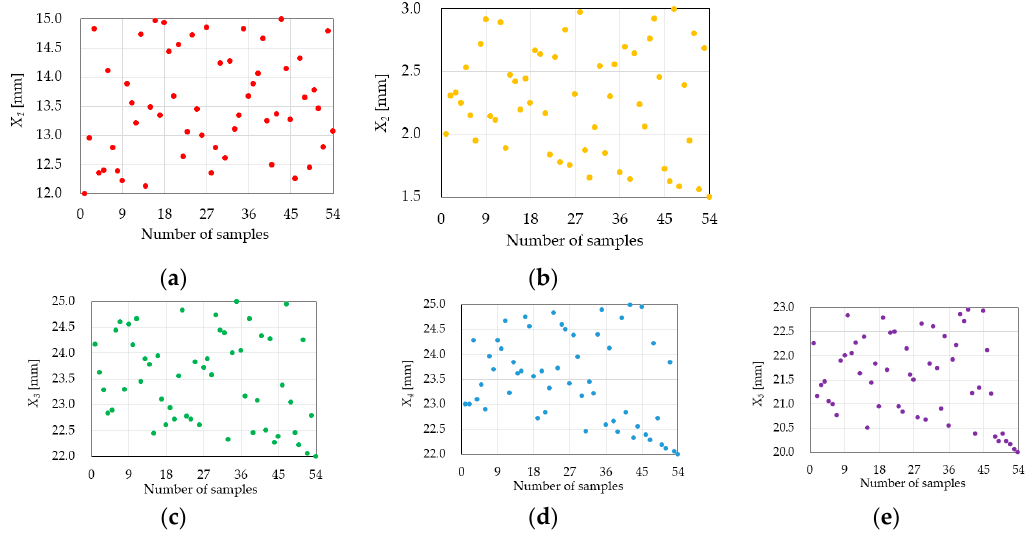
Figure 5. Sample distribution maps of optimal Latin hypercube design (OLHD): ( a ) X 1 ; ( b ) X 2 ; ( c ) X 3 ; ( d ) X 4 ; ( e ) X 5 .